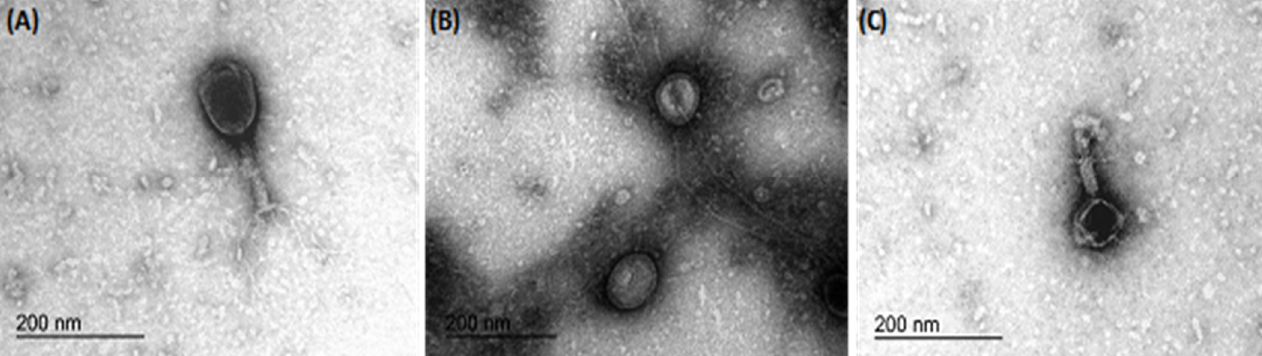
Figure 2. Representative scanning electron microscopy images of ( A ) E. coli CFT073, ( B ) E. coli LF82, and ( C ) E. coli MG1655 lysed by IBEC 77, IBEC 36, and IBEC 48 phage, respectively, and releasing its intracellular content as observed in these images. Bar =1 µm.